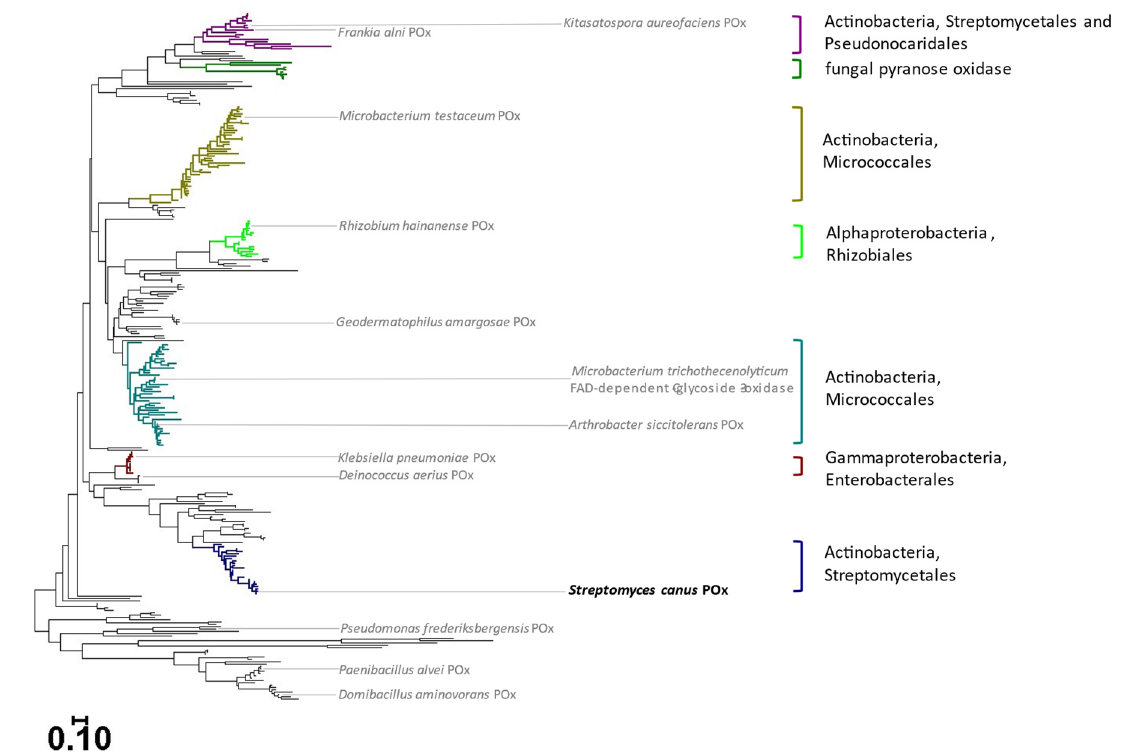
Figure 1. Phylogenetic tree of putative pyranose oxidase sequences, depicting the diversity of bac- terial pyranose oxidases. Fungal sequences are represented by dark green branches. The positions of previously characterized POx from Arthrobacter siccitolerans and Kitasatospora aureofaciens are in- dicated in the tree as well as that of the FAD-dependent C-glycoside 3-oxidase from Microbacterium trichothecenolyticum (grey, right side of enzyme names). The position of POx from Streptomyces canus , which was characterized in this study, is shown in black, as are the positions of the nine sequences used in the initial screening for activity (grey, left side of enzyme names). Sequences from a charac- terized fungal cellobiose dehydrogenase and bacterial cholesterol oxidases were used as outgroups. The bar represents phylogenetic distance as amino acid substitution per site.